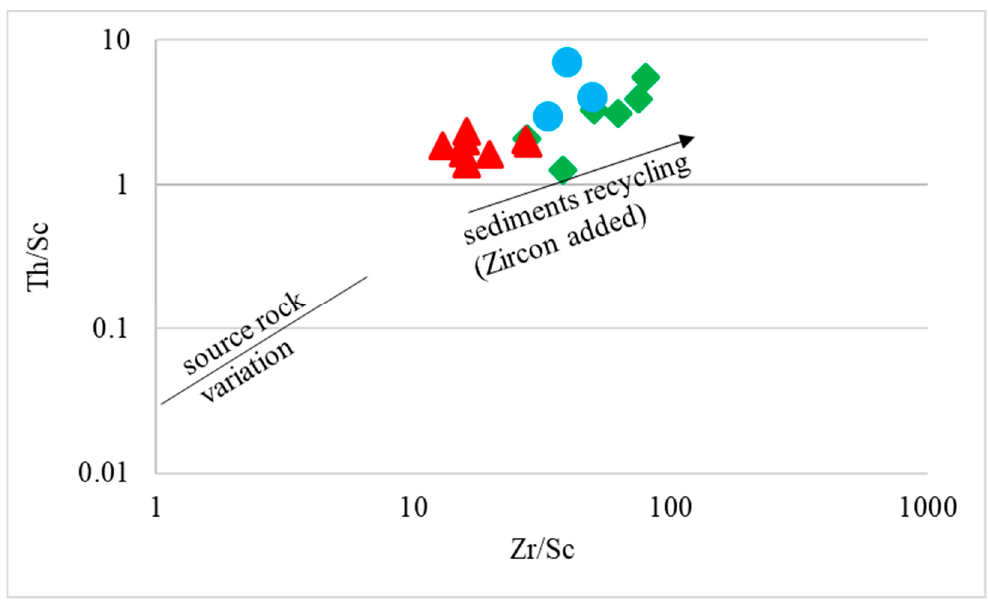
Figure 15. Plot of the Th/Sc ratio against the ratio of Zr to Sc for the Chichali Formation.